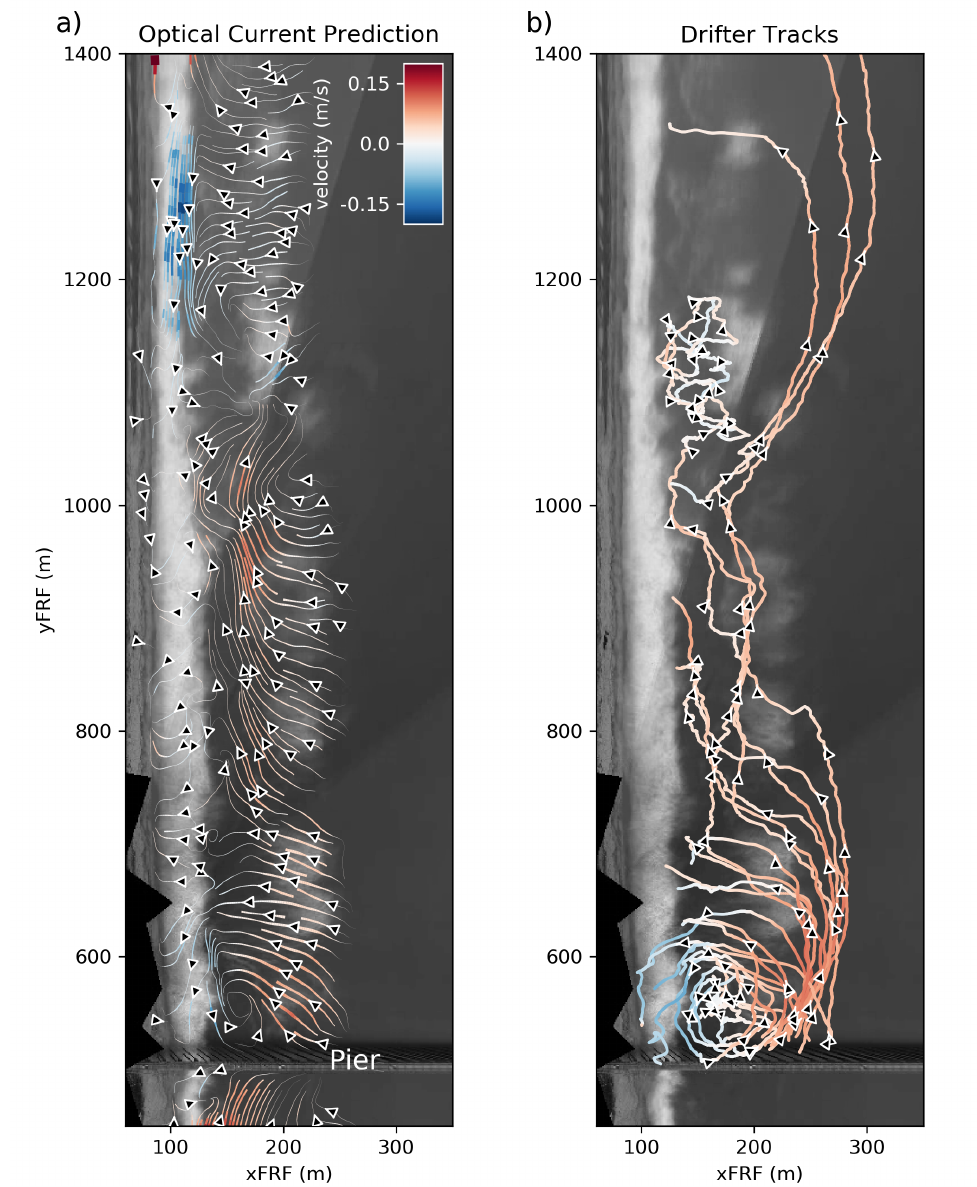
Figure 5. Comparison of spatial currents derived from ( a ) optical flow applied to a wave-averaged movie and ( b ) a drifter deployment on 22 October 2019 at 15:30. The optical velocity estimates in ( a ) are provided as a stream plot where line width corresponds to relative total velocity magnitude and color depends on the strength of the alongshore component of velocity to aide in emphasizing the direction of flow. both ( a , b ) are plotted on the initial frame of the wave-average movie to highlight the spatial variability of foam